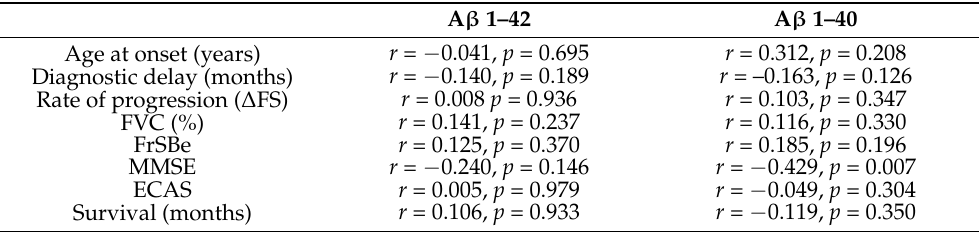
Table 3. Spearman’s correlation of the CSF A β 1–42 and A β 1–40 with demographic, clinical and neuropsychological features of ALS patients.